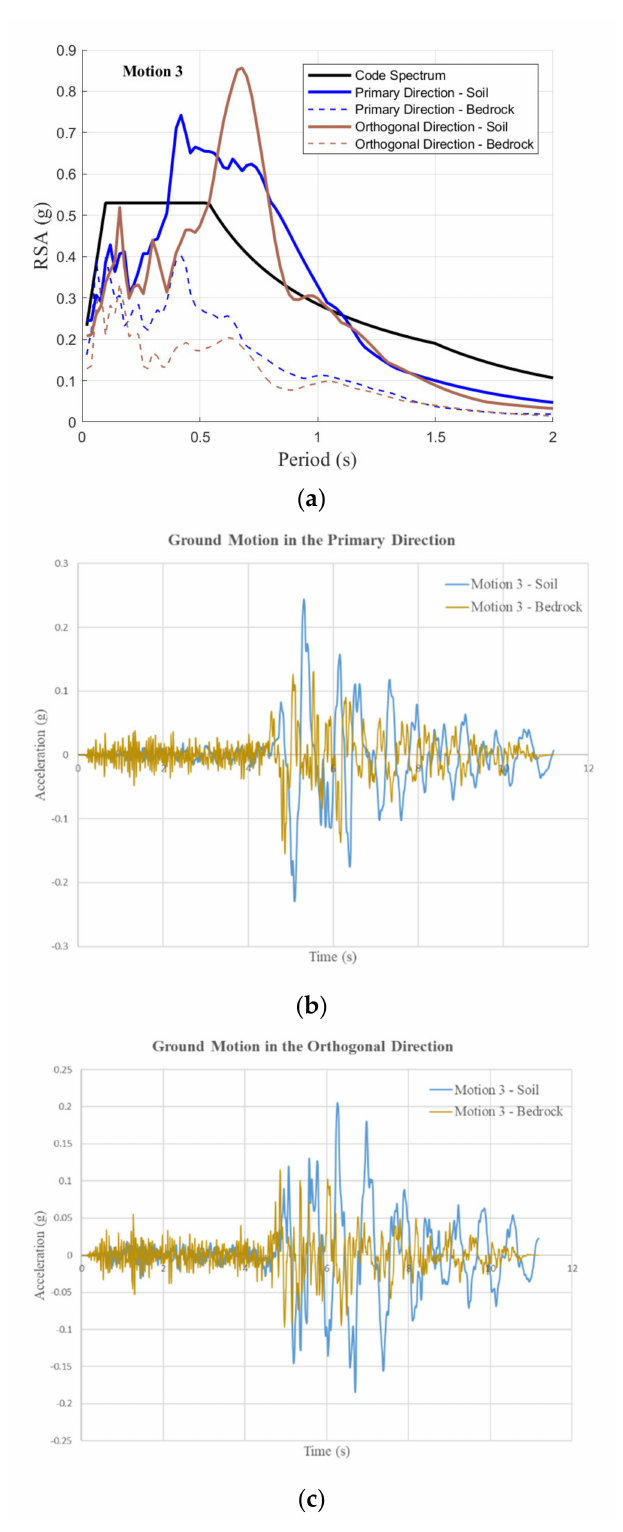
Figure 8. Case Study Output—Motion 3: ( a ) comparison of the response spectra (in term of pseudo acceleration) of the bedrock and soil surface motion in both primary and orthogonal directions with the class D e spectrum; ( b ) soil surface accelerograms in the primary direction; ( c ) soil surface accelerograms in the orthogonal